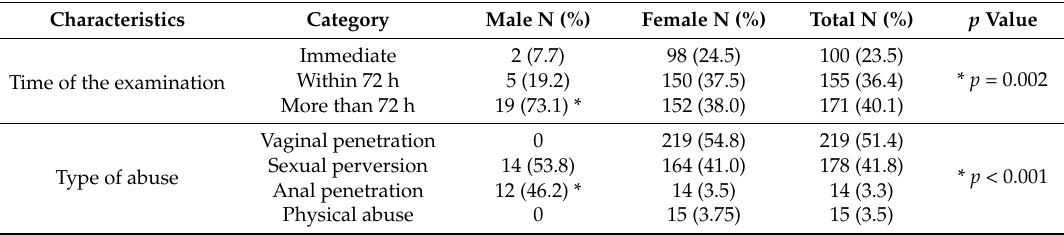
Table 2. Characteristics of CSA